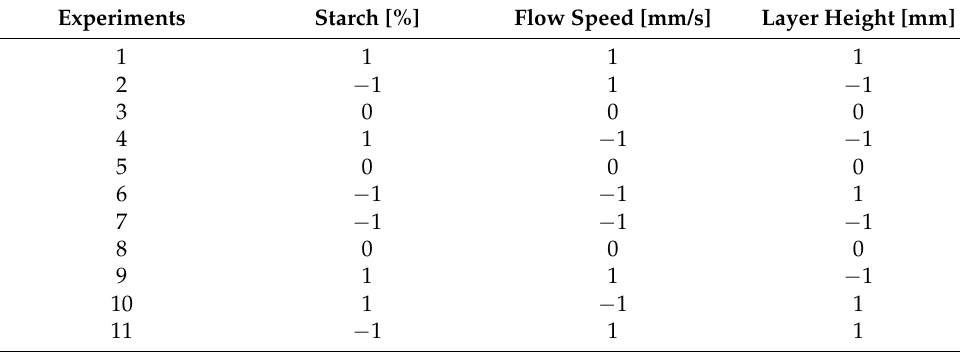
Table 5. Design of experiments; levels applied for each